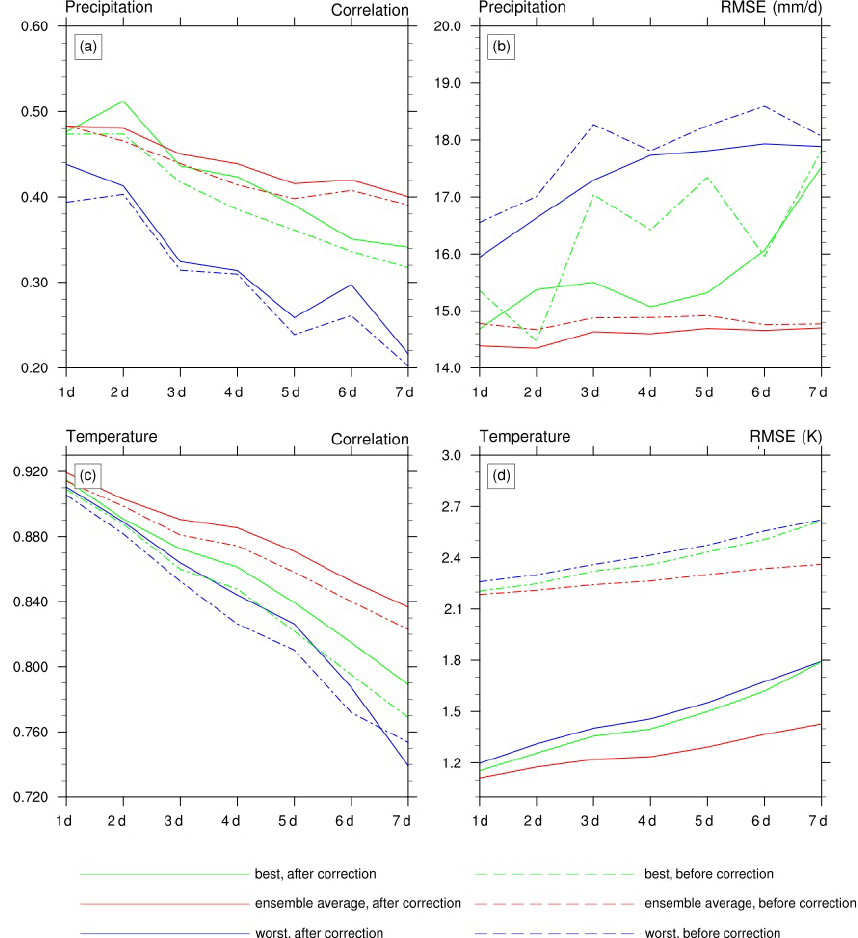
Figure 6. Evaluation of precipitation and temperature hindcasts from TIGGE-ECMWF. The red and blue lines represent the best and worst results among the 51 TIGGE-ECMWF ensemble members, respectively, and the green lines represent the results for the ensemble means of 51 members. Solid and dashed lines represent the results after and before bias corrections,